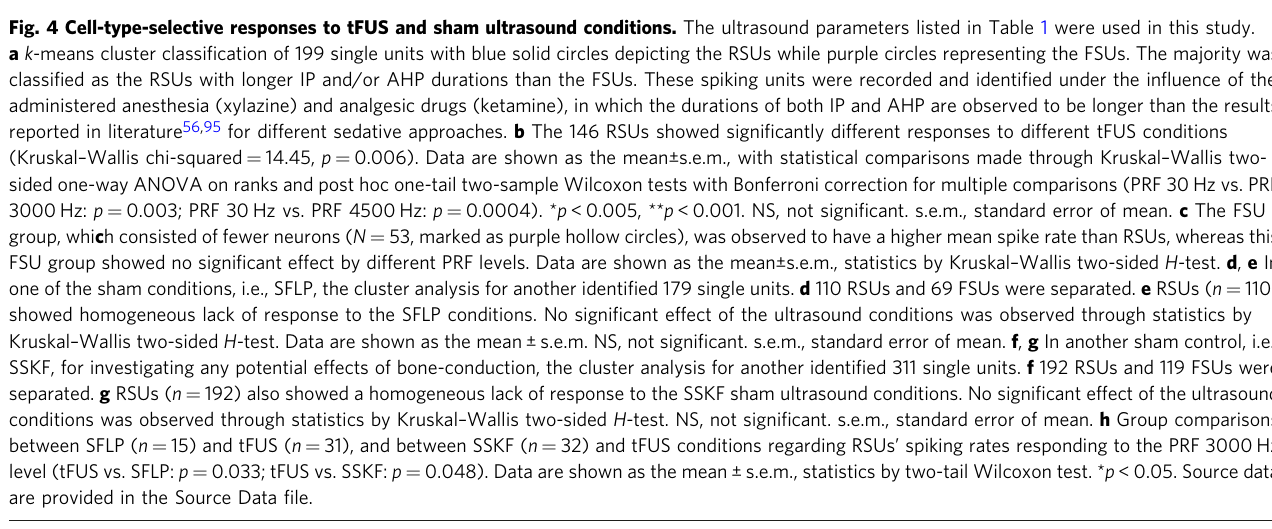
Fig. 4 Cell-type-selective responses to tFUS and sham ultrasound conditions. The ultrasound parameters listed in Table 1 were used in this study. a k -means cluster classi fi cation of 199 single units with blue solid circles depicting the RSUs while purple circles representing the FSUs. The majority was classi fi ed as the RSUs with longer IP and/or AHP durations than the FSUs. These spiking units were recorded and identi fi ed under the in fl uence of the